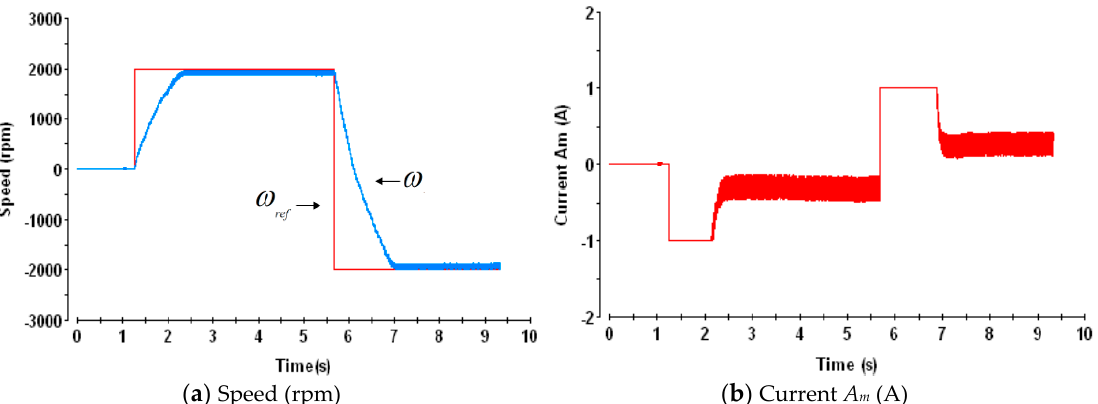
Figure 21. Speed and current when the rotating direction is changed with load.